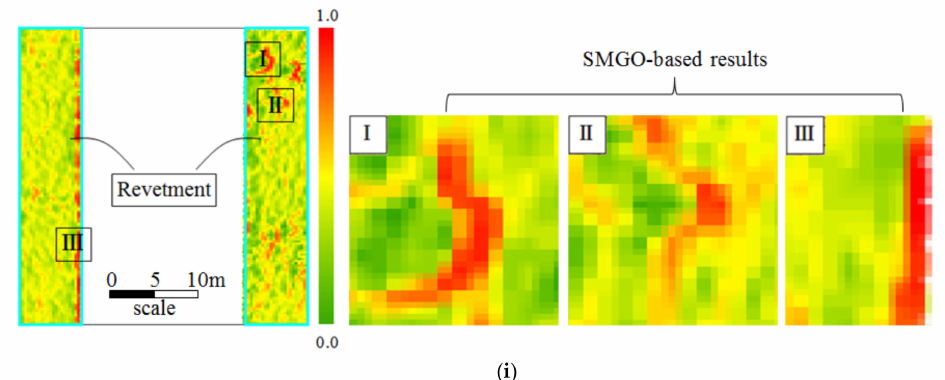
Figure 11. Revetment damage recognition along an urban river. The dense point clouds, depth map, and slope intensity image of the subarea in Figure 10a are shown in ( a , b , e ), respectively. ( c ) Cross-section without damage. ( d ) Cross-section with a collapse. ( f ) Superpixels marked by the cyan boundaries that are generated via the simple linear iterative clustering (SLIC)-based algorithm. The true color (RGB) point cloud of the revetment is exhibited in ( g ), and the enlarged three damaged regions of I, II, and III from the ground field observation are also shown in ( g ). In addition, the gradient intensity images generated using the non-multiscale gradient operator (NMGO) and SMGO are shown in ( h , i ), respectively.